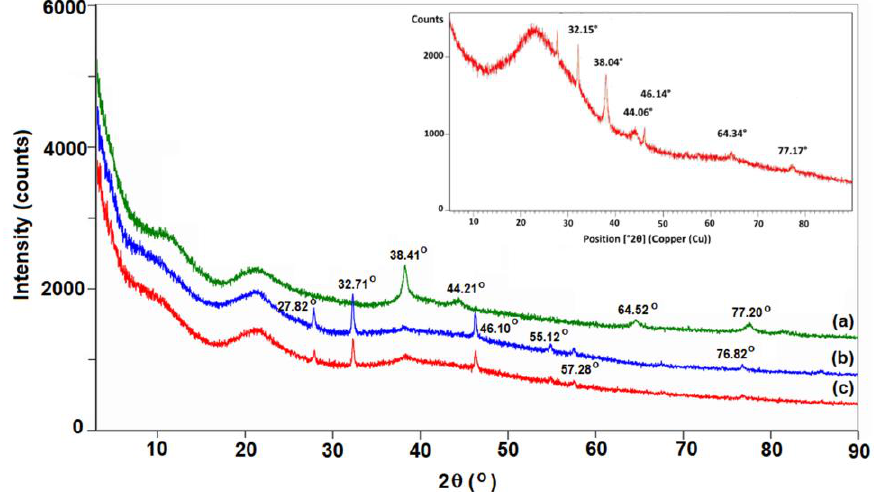
Figure 6. XRD spectrum of studied materials: ( a ) PVP-AgNPs, ( b ) HPMC-AgNPs, ( c ) 70 HPMC/30 PVP-AgNPs. Inserted graph represents the XRD pattern of AgNPs according to the standard ICSD No. 98-018-0878.